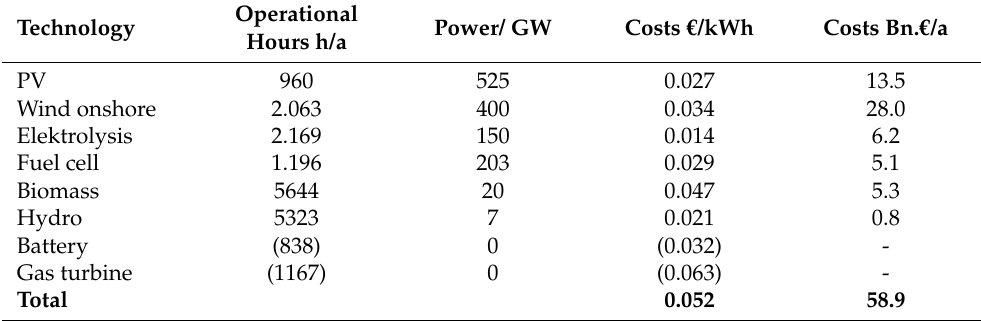
The operational hours are based on specific energy yields form ISE Fraunhofer Energy Charts between 6 August 2018 and 5 August 2019 with wind: 123.72 TWh/59.96 GW, photovoltaics: 46.05 TWh/47.96 GW, hydro power: 25.55 TWh/4.80 GW, and power